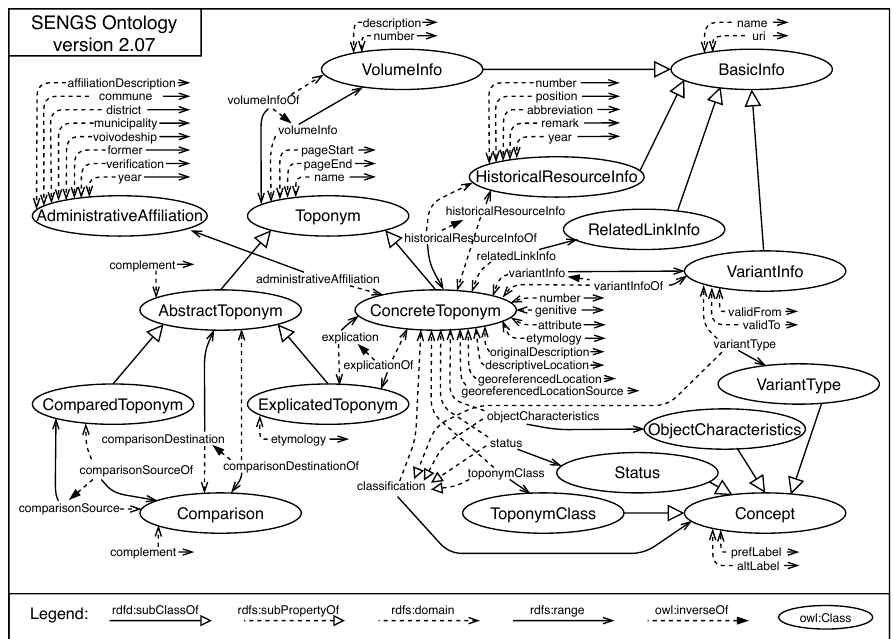
Figure 6. Diagram representing the core classes and properties of the SENG´S